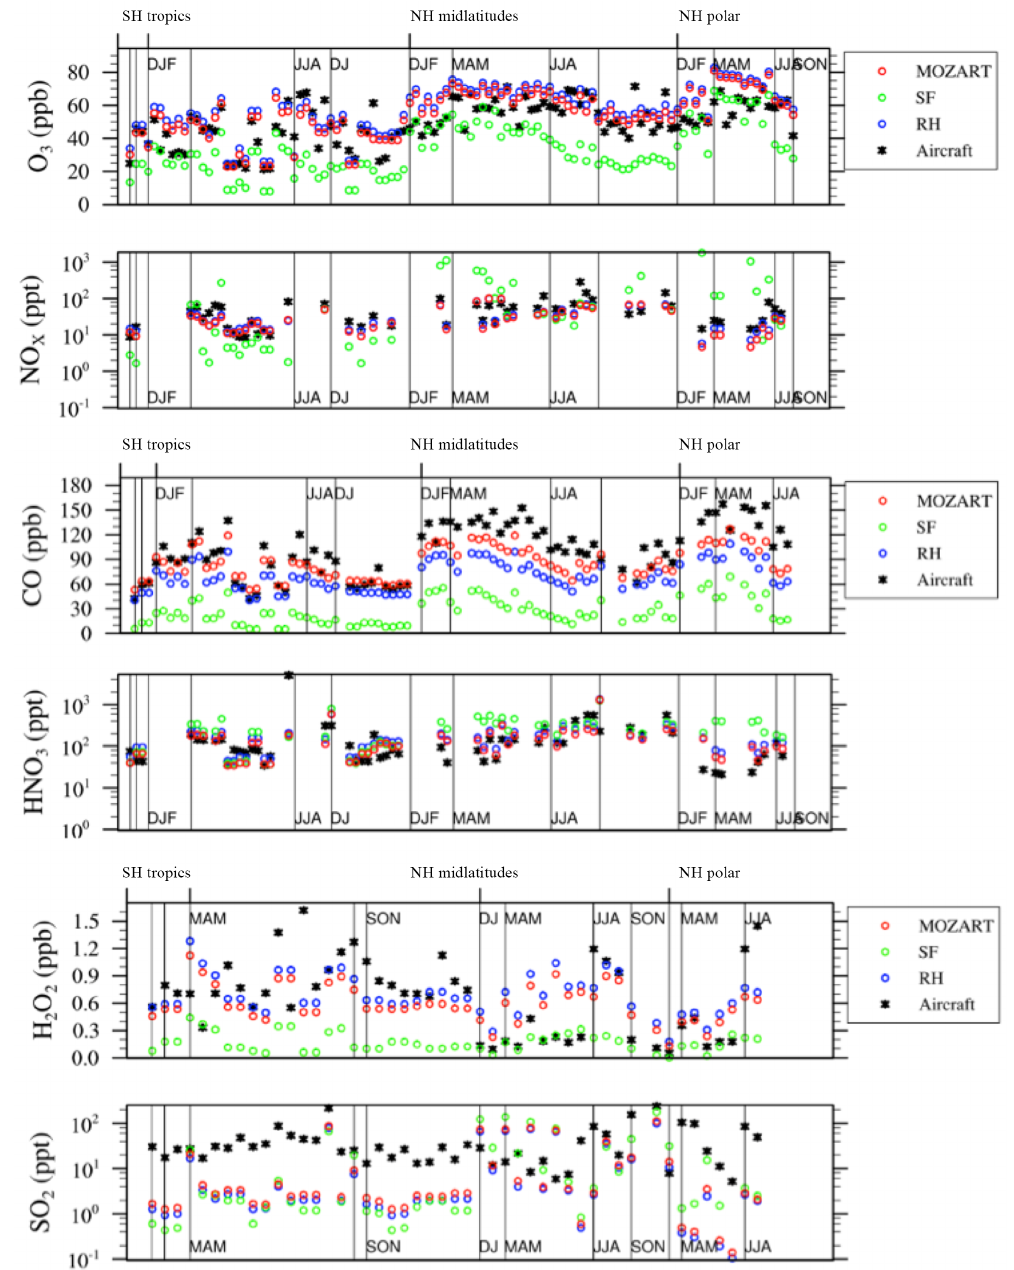
Figure 3. Relative differences between available aircraft observations (black) and the MO, RH, and SF model configurations (colors) over different regions and seasons, averaged over 2–7km, for O 3 , NO x , CO, HNO 3 , H 2 O 2 , and SO 2 as in Fig. 17 of Tilmes et al.